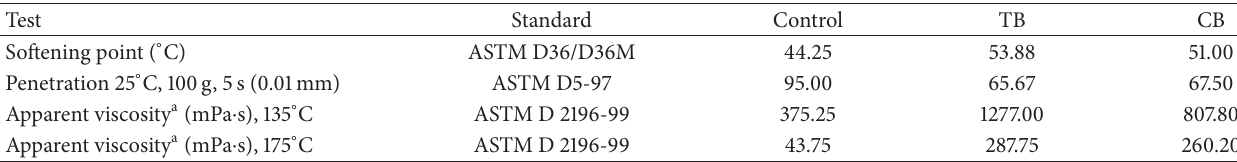
Table 5: Characterization of the